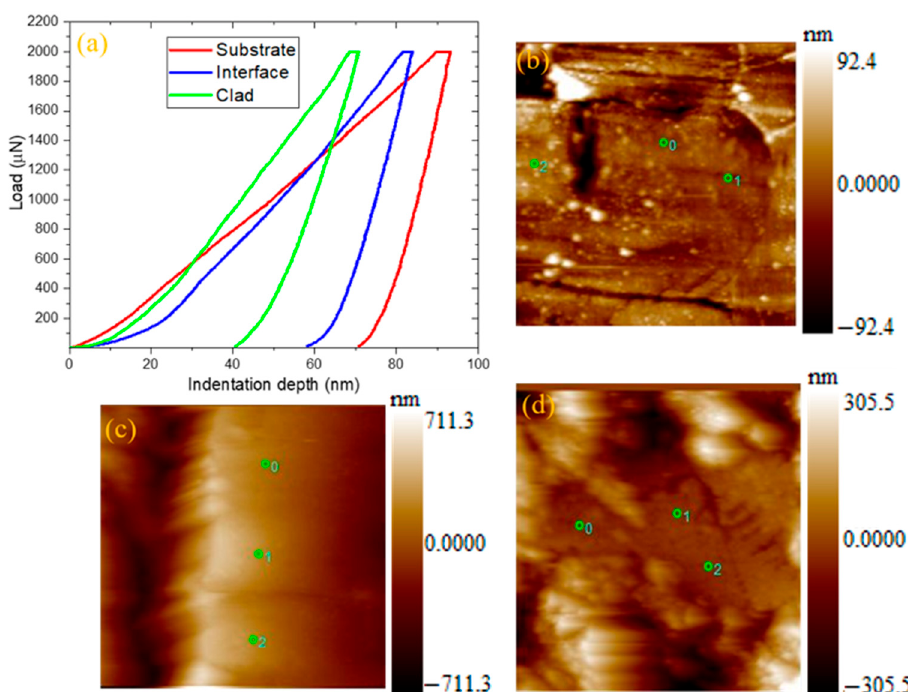
Figure 5. ( a ) Load to depth plot at the substrate, interface and cladded region obtained from the nanoindentation test, SPM images of indentation at ( b ) substrate, ( c ) interface, and ( d ) clad